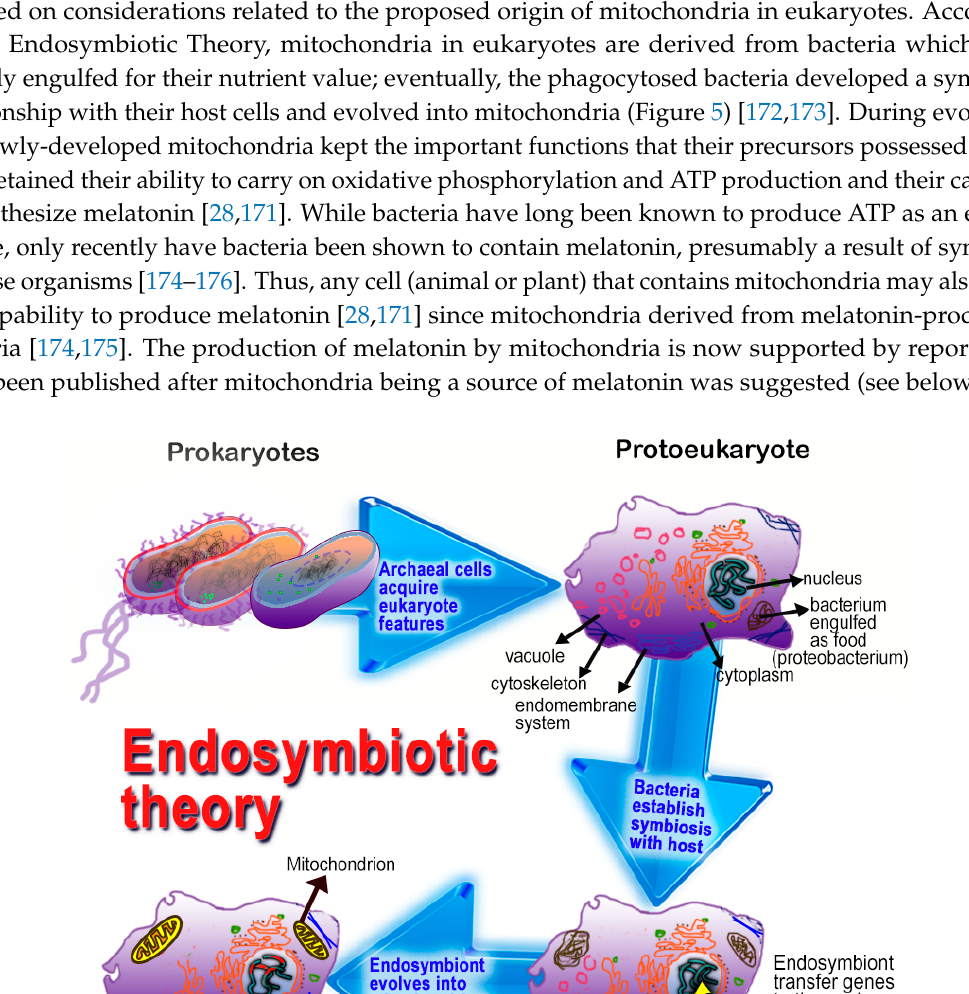
in their mitochondria. The Endosymbiotic Theory for the origin of mitochondria was suggested